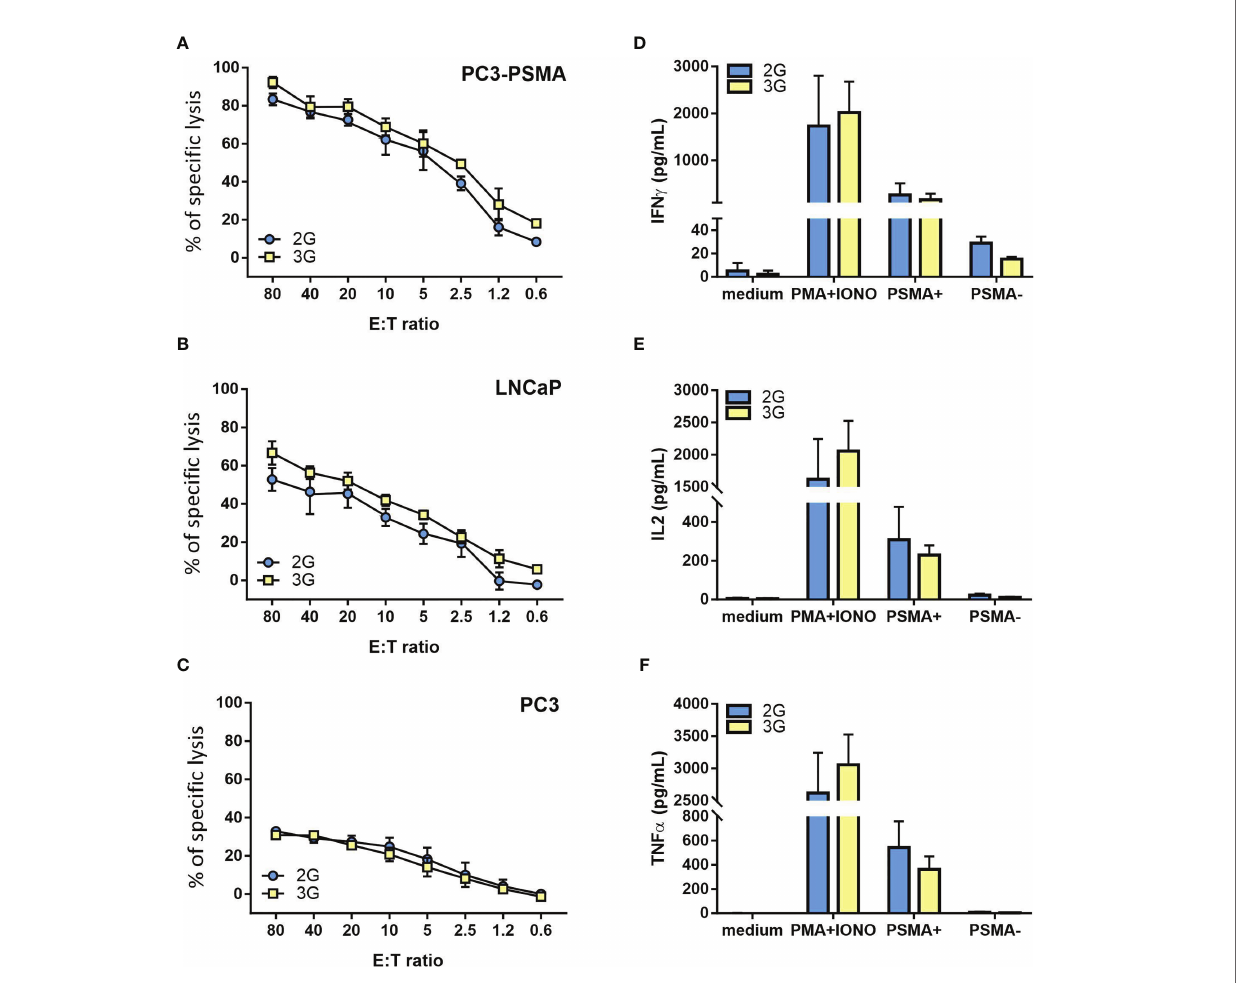
FIGURE 3 | Functional characterization of the 2G and 3G CAR-expressing populations. (A – C) Lytic activity of the 2G (light blue) and 3G (yellow)-CAR expressing populations. Cytotoxicity was analyzed at day 15 post-transduction; as target cells, (A) PC3-PSMA, (B) LNCaP, and (C) PC3 were used. (D – F) Cytokine release upon antigen stimulation. (D) IFN- g , (E) IL-2 and (F) TNF- a . Cytokine release was evaluated 15 days after T cell infection by stimulating 2G and 3G CAR populations with PC3-PSMA or PC3 cancer cell lines. Negative and positive controls were represented by 2G and 3G CAR T cells treated or not with PMA/Ionomycin. Figures show the mean +/- SD of 3 independent